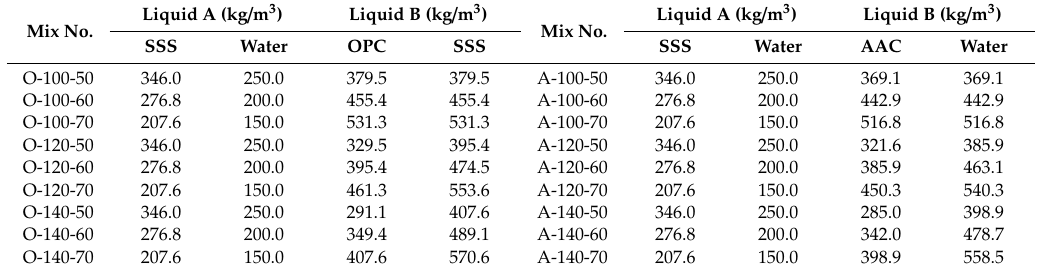
Table 4. Mixing proportions.